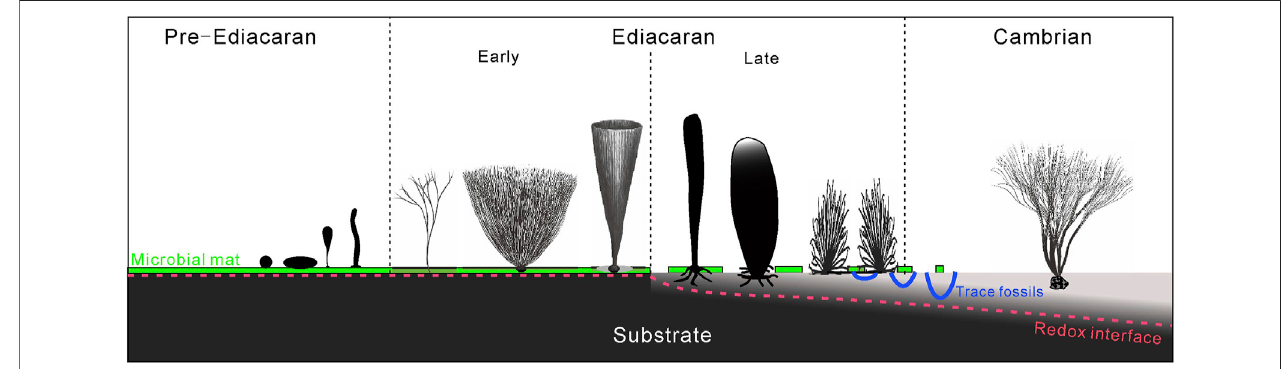
FIGURE 7 | Schematic illustration of macroalgal holdfast morphology and attachment strategy responding to a changing substrate condition.